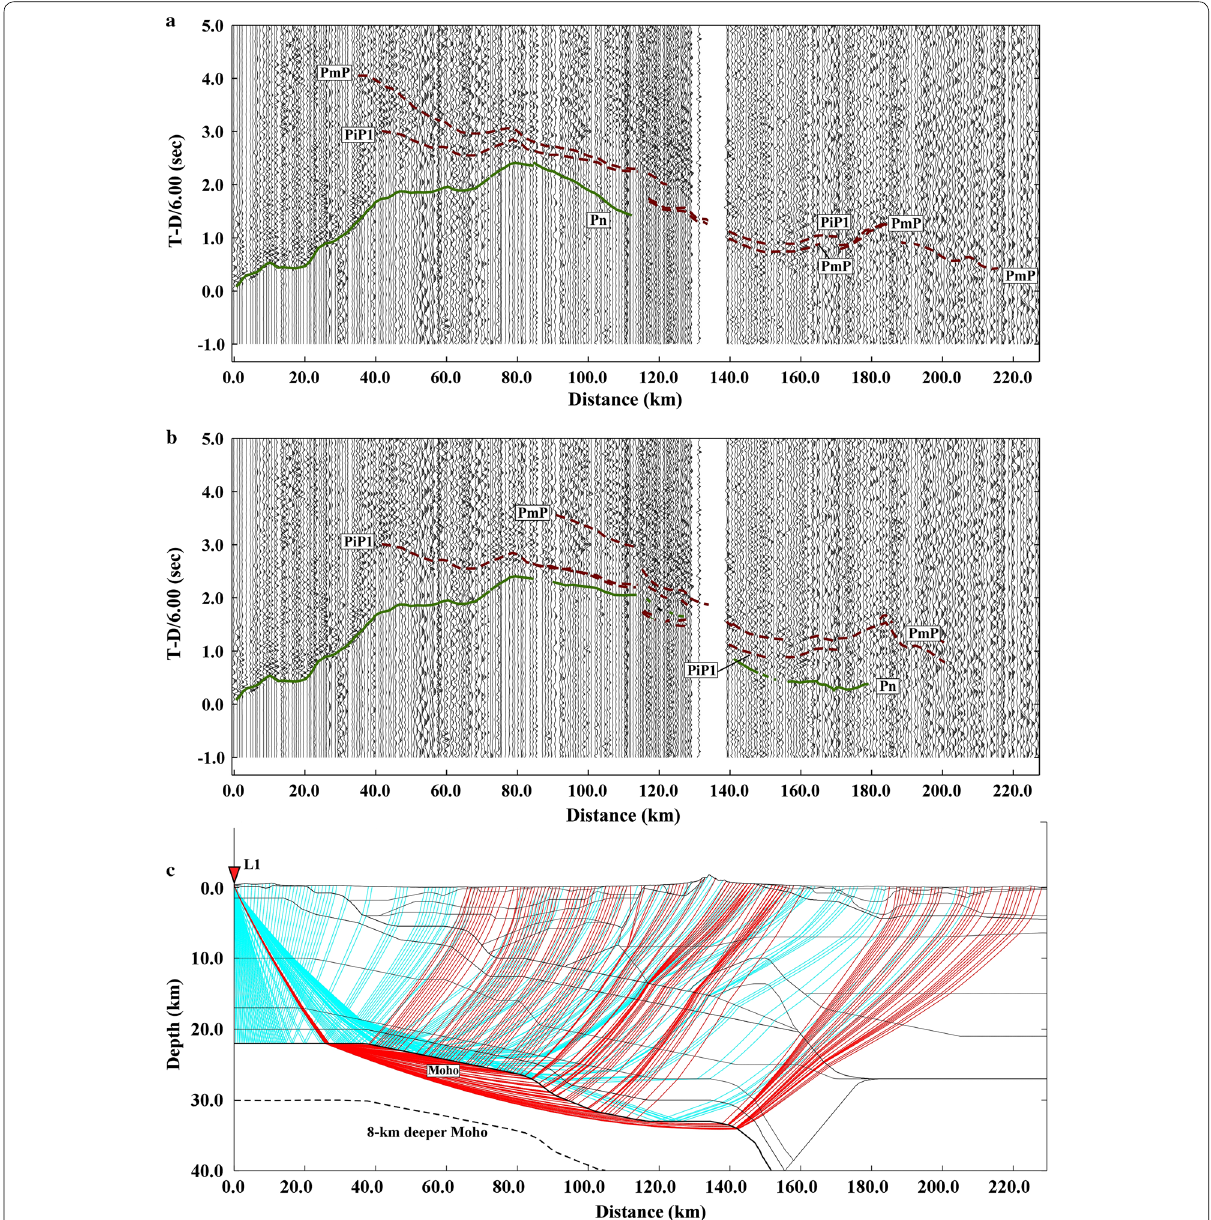
Fig. 7 Record section with theoretical travel times and ray diagrams for shot L1. a Record section on which travel time curves predicted from the velocity model (Fig. 5a) are shown. Theoretical travel times for first arrival and late phase are shown by a green and brown curves, respectively. See also the phase identifications in Fig. 6a. Phase “A” is interpreted to be Pn wave (refracted wave from the upper mantle), while phases “B” to “D” are are explained by superposition of PiP1 and PmP waves (reflected waves from the interfaces R1 and Moho, respectively). See also ray diagrams in c . b Record section on which travel time curves from a velocity model with 8-km deeper Moho (see c ) are shown. Theoretical travel times for first arrival and late phase are shown by a green and brown curves, respectively. See also the phase identifications in Fig. 6a. Phase “B” in Fig. 6a is interpreted to be the PiP1 phase. The onset of wave train of phase “C” is explained by Pn wave while its later part by PmP wave. c Ray diagrams for PmP (light blue) and Pn (red) waves. Interfaces corresponding to PiP1 wave is indicated by R1. A broken curve shows the Moho location 8 km shifted downward (see the text for detailed explanation), which corresponds to the case of